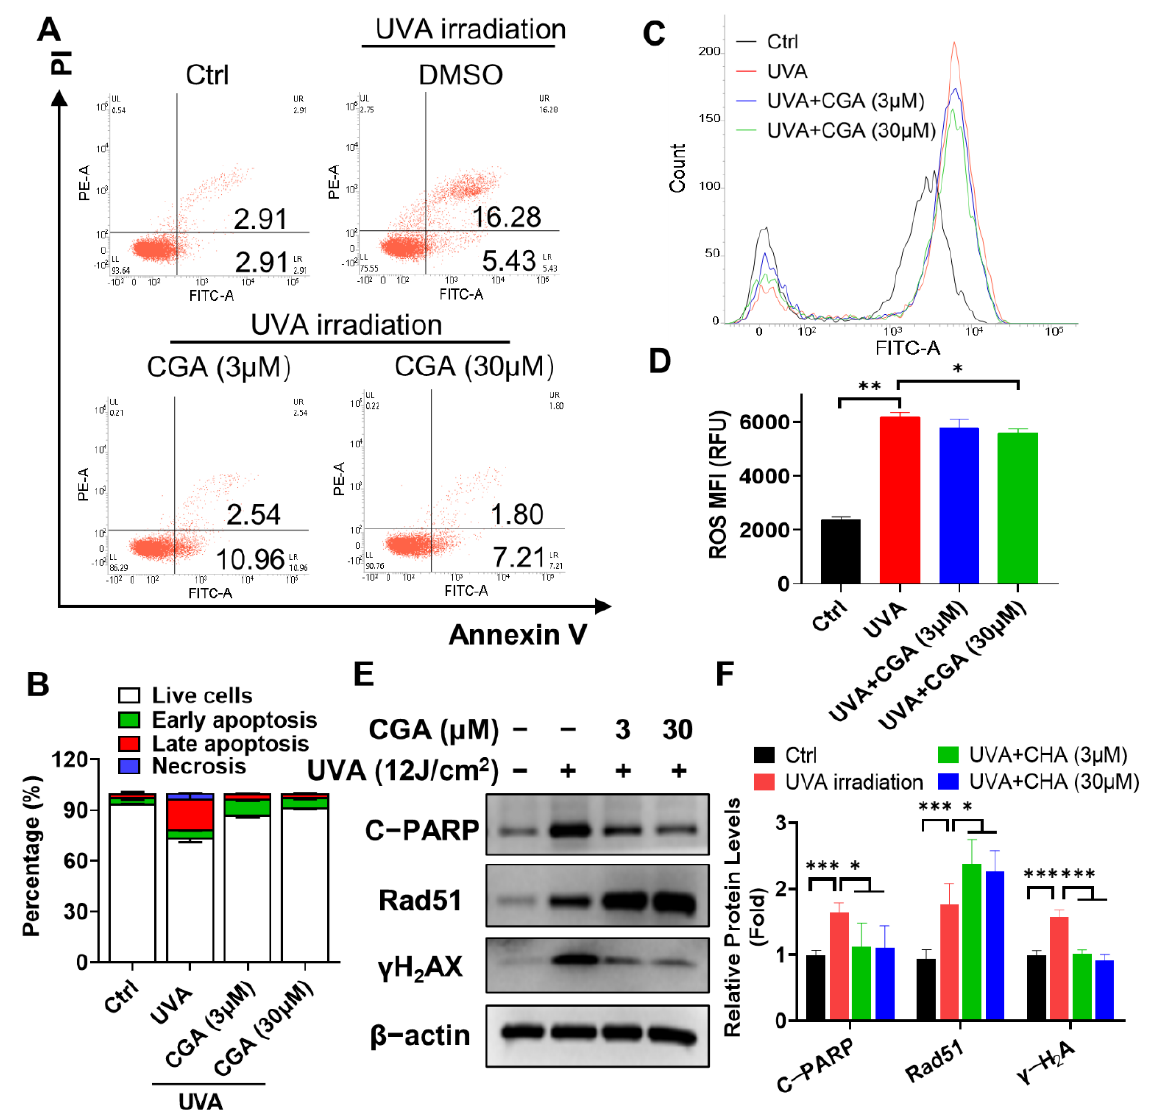
Figure 6. The effect of CGA on cell apoptosis and ROS production in UVA-irradiated HDF- α cells. HDF- α cells were irradiated by UVA for 60 min, followed by treatment with CGA for 24 h, and harvested for apoptosis and ROS analysis. ( A ) The percentage of cell apoptosis were determined by an annexin V-FITC/PI double staining assay followed by flow cytometry. ( B ) Statistical analysis of the live cells, early and late apoptotic cells and necrosis cells in various treatment groups. Data are expressed as the mean from three experiments. ( C ) ROS production was evaluated using DCFH-DA probe by flow cytometry assay. ( D ) The ROS mean fluorescent intensity (MFI) were calculated from three experiments and shown in the histogram. * p ≤ 0.05, ** p ≤ 0.01 indicate a significant difference. ( E ) The protein expressions of cleaved PARP, γ -H 2 AX and Rad51 in UVA-irradiated HDF- α cells were determined by western blot assay using specific antibodies. ( F ) Relative protein expressions were quantified by densitometry and shown in the histogram. Data are expressed as the mean from three experiments. * p ≤ 0.05, *** p ≤ 0.001 indicate a significant difference.